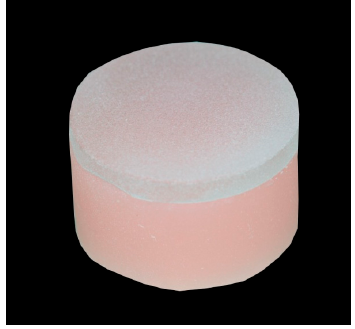
Figure 1. Specimen with PET surface.